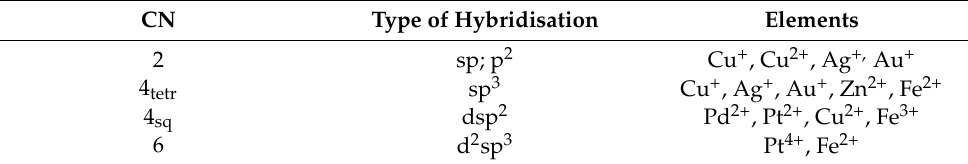
Table 30. Coordination number and type of hybridisation of some metals. CN